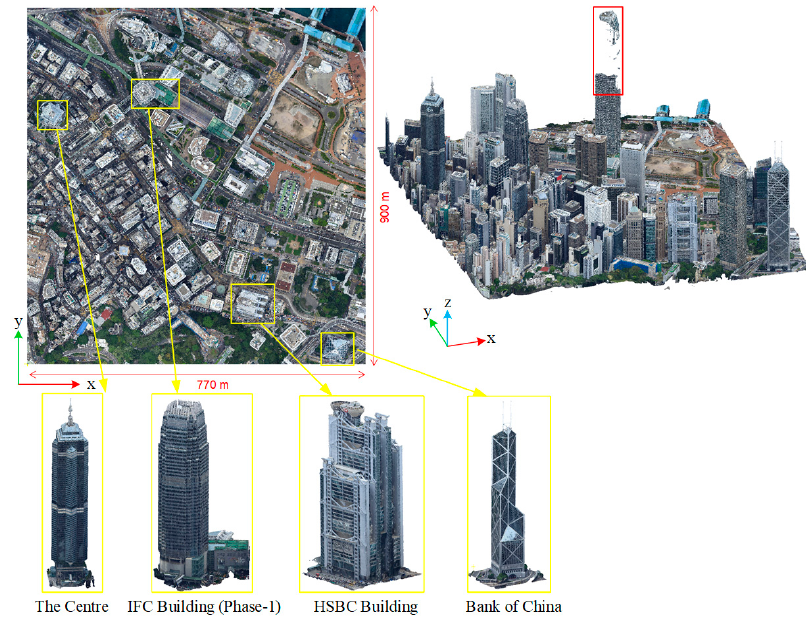
Figure 14. Overview of the dataset acquired in central Hong Kong.